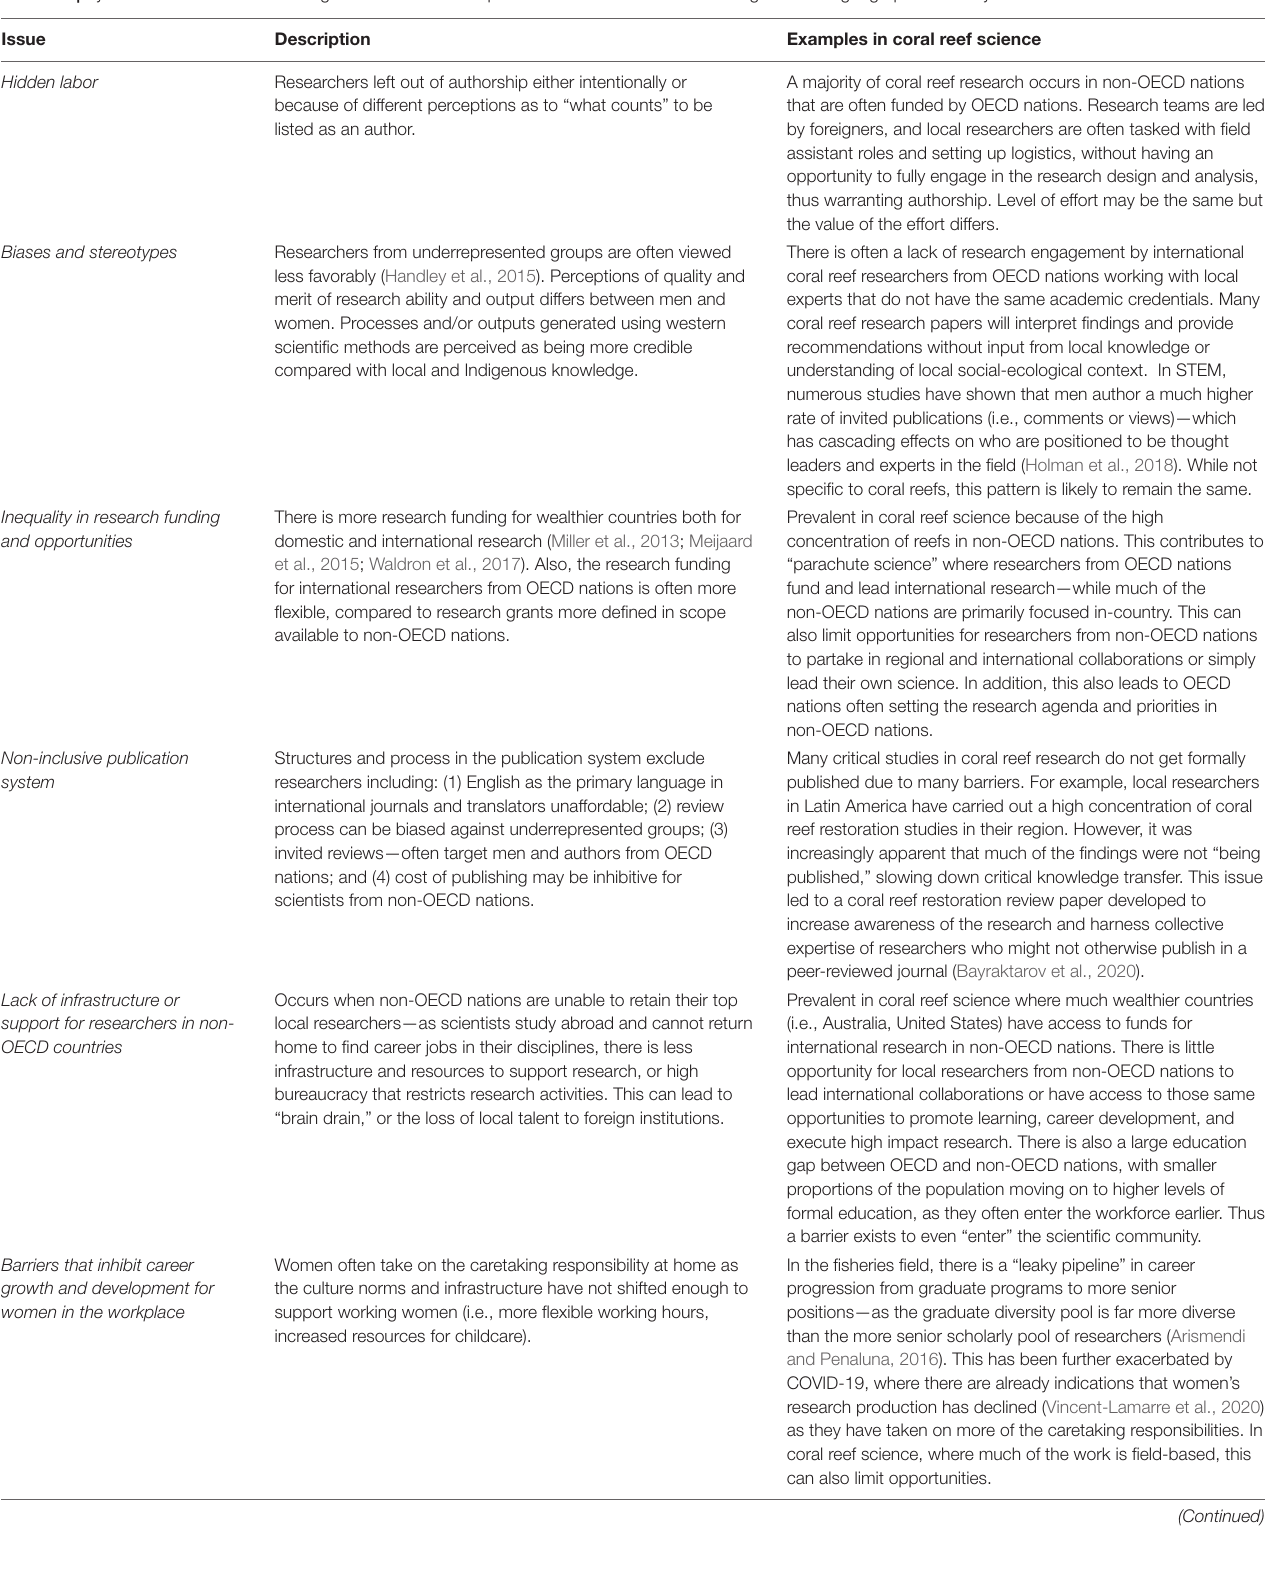
TABLE 1 | Systemic issues of neocolonial/globalization research practices that contribute to lack of gender and geographic diversity in coral reef